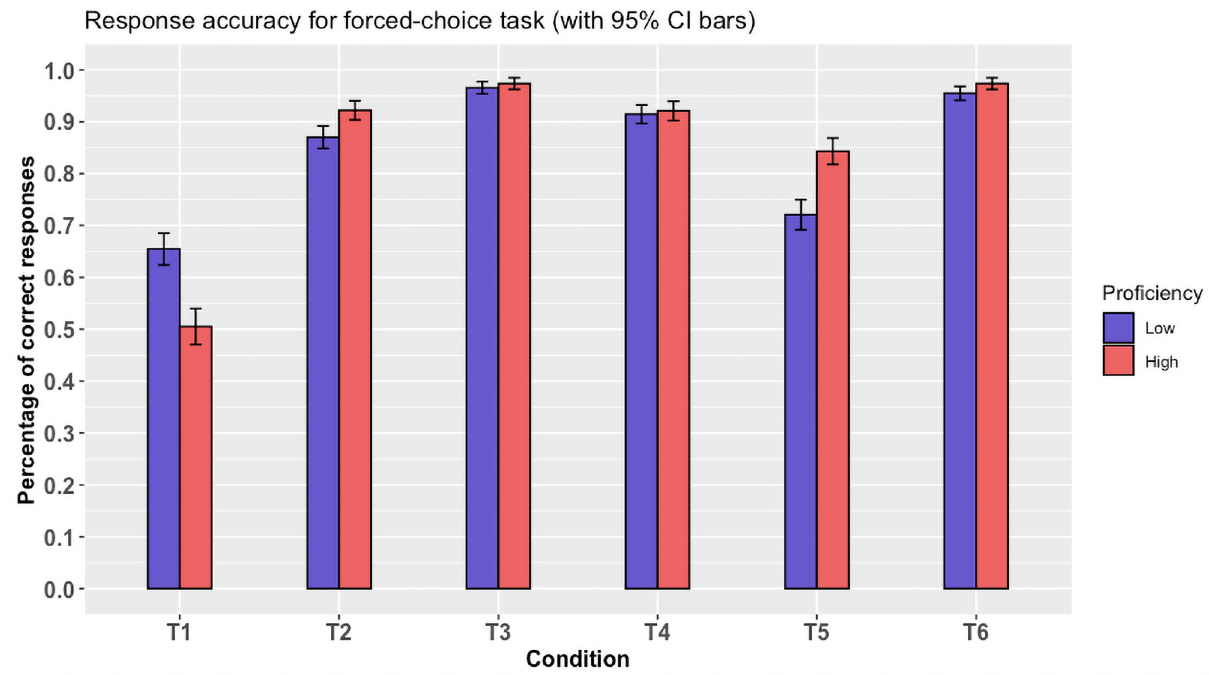
Fig 2. Choice proportions as a function of condition (T1-T6) and proficiency (low vs. high). Note that for the T1 condition, pragmatic responses were coded as ‘0’ and logical responses as ‘1’.